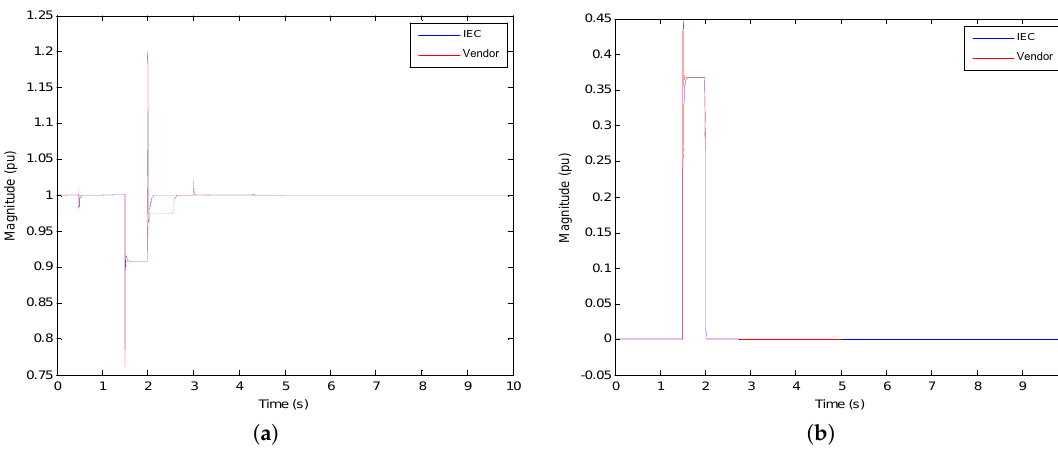
Figure 15. Type IVA results. Simulation scenario: p = 1.0 pu, u = 0.85 pu, t = 500 ms. ( a ) Active power, p ; and ( b ) reactive current, i q